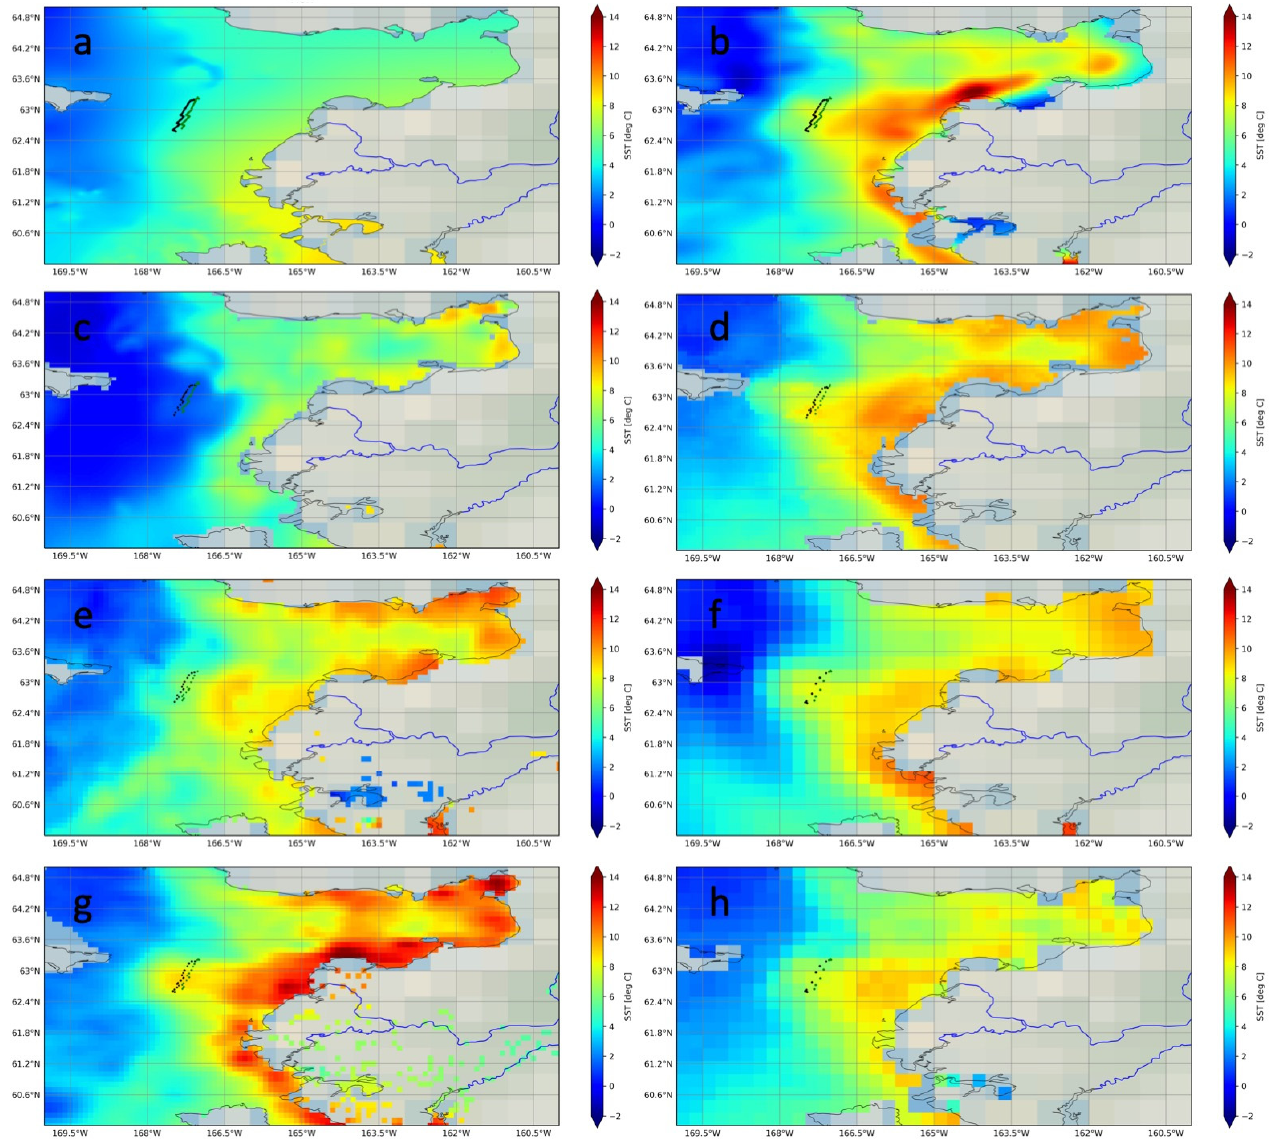
Figure 4. ( a – h ) L4 SST images around the Y–K delta for DOY 151 (31 May 2019) for: ( a ) MUR, ( b ) OSTIA, ( c ) DMI, ( d ) MWIR, ( e ) K10, ( f ) DOISST, ( g ) CMC, and ( h ) GMPE. The black dotted line shows the transect of SD1036 for the same day. The green dotted line shows the corresponding track for SD1037. Each saildrone matching position is in the corresponding resolution of the L4 product. For identification of the Yukon river in the image, see Figure 1c.